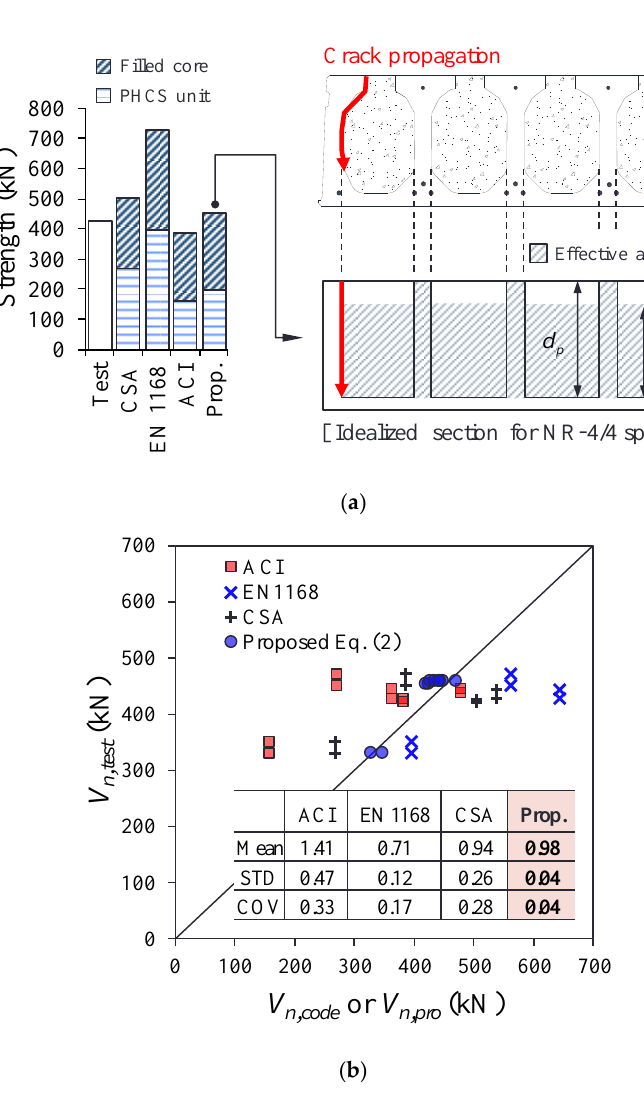
Figure 11. Proposed method for estimating shear strength of PHCS with filled cores. ( a ) Estimation of shear strength of PHCS with four filled cores. ( b ) Comparison of test and calculation results.